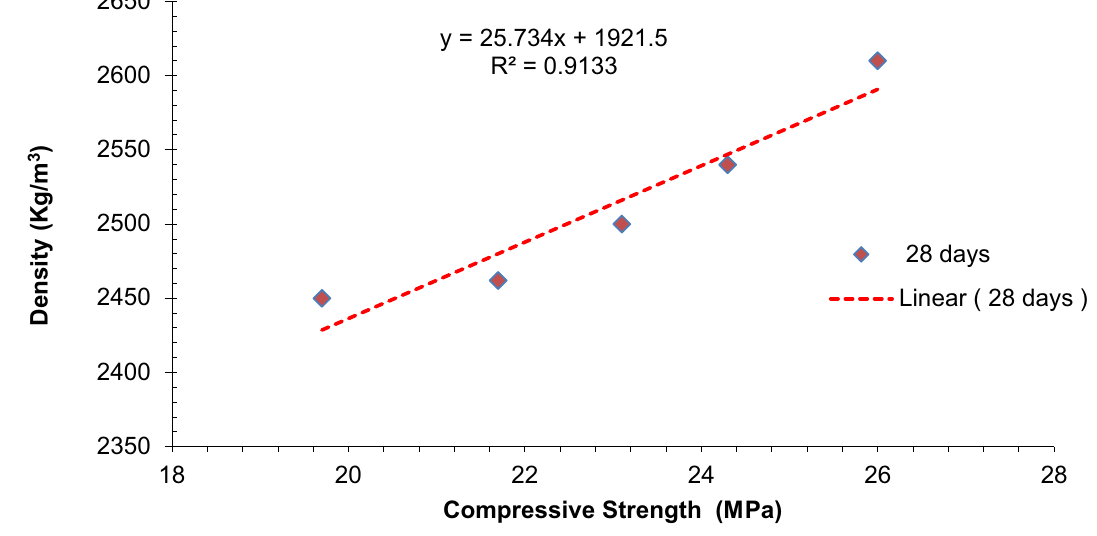
Figure 9. Co-relation between density and compressive